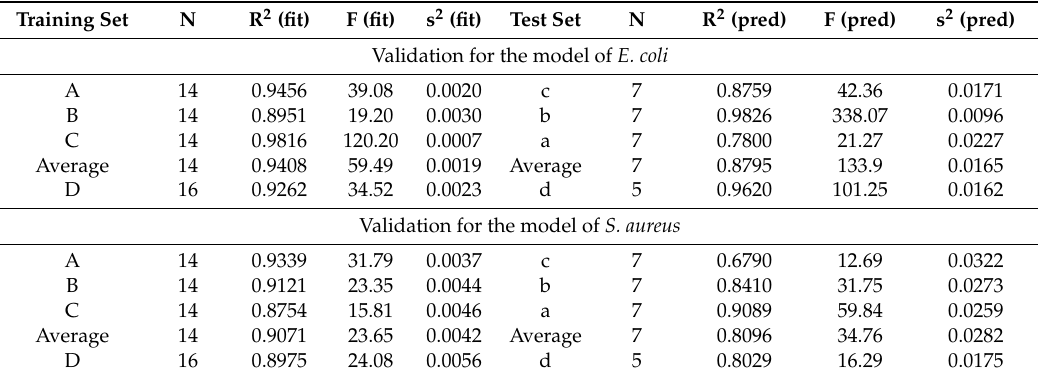
Table 3. The internal validation results of best QSAR models.